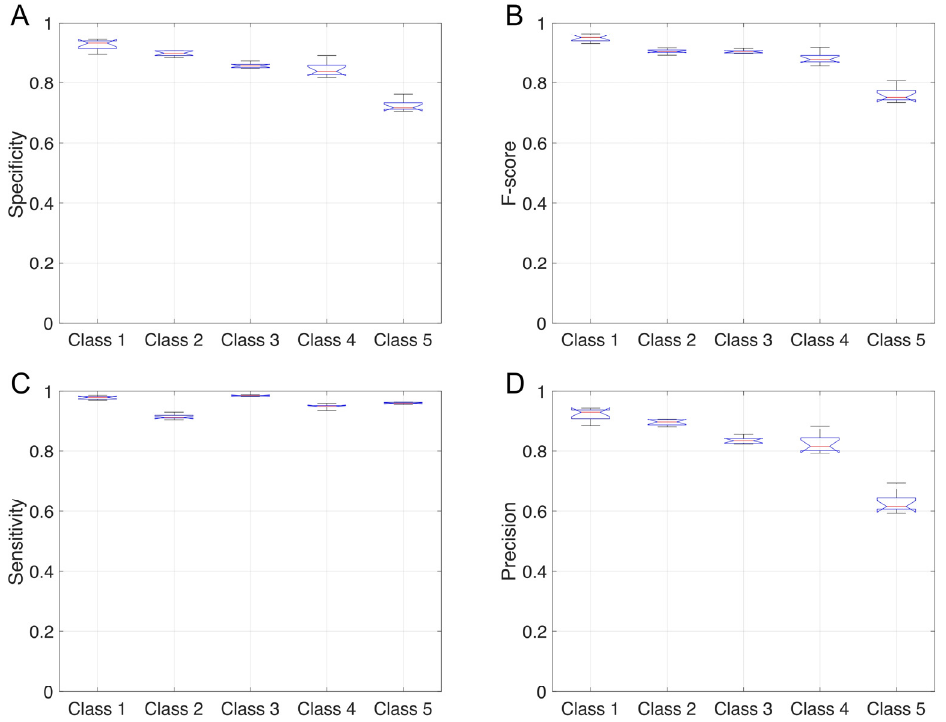
Figure 9. The four panels clockwise from the top present the Specificity (Panel ( A )), F-score (Panel ( B )), Sensitivity (Panel ( C )), and Precision (Panel ( D )) achieved for each class with the 2BLSTM2D network.